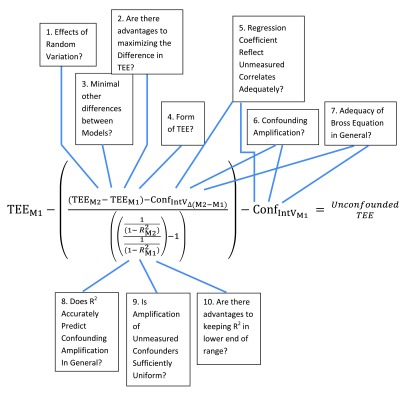
ACCE Method Summary Equation Annotated with Key Uncertainties.Abbreviations for
Appendix Figure 1a and
Appendix Figure 1b:TEE = Observed Treatment Effect Estimate, observed from outcome models when the particular propensity score model noted by the subscript is used to stratify or match the samples being compared.Unconfounded TEE = The Estimate of the Treatment Effect Unconfounded by Baseline Confounding through operation of the ACCE Method.M1 = Model 1.M2 = Model 2.IntV = Introduced Variable.Conf
IntV
Δ(M2-M1) = the change in confounding between Model 2 and Model 1 attributable to the change (i.e., expected decrease) in the imbalance of the Introduced Variable between Model 1 and Model 2. This is calculated through knowledge of the imbalance of the variable in both models and use of the Bross equation. Specifically,Conf
IntV
M1 = Confounding attributable to the Introduced Variable in Model 11 - R
2 = 1 minus the R
2 observed for the propensity score model, i.e., the R
2 for the prediction of treatment exposure. The reciprocal of (1 - R
2), i.e. 1 / (1 - R
2) is the predictor of the amplification of confounding occurring during stratification or matching using that propensity score model. The subscript M1 and M2 denote the R
2 for the propensity score Model 1 and propensity score Model 2.